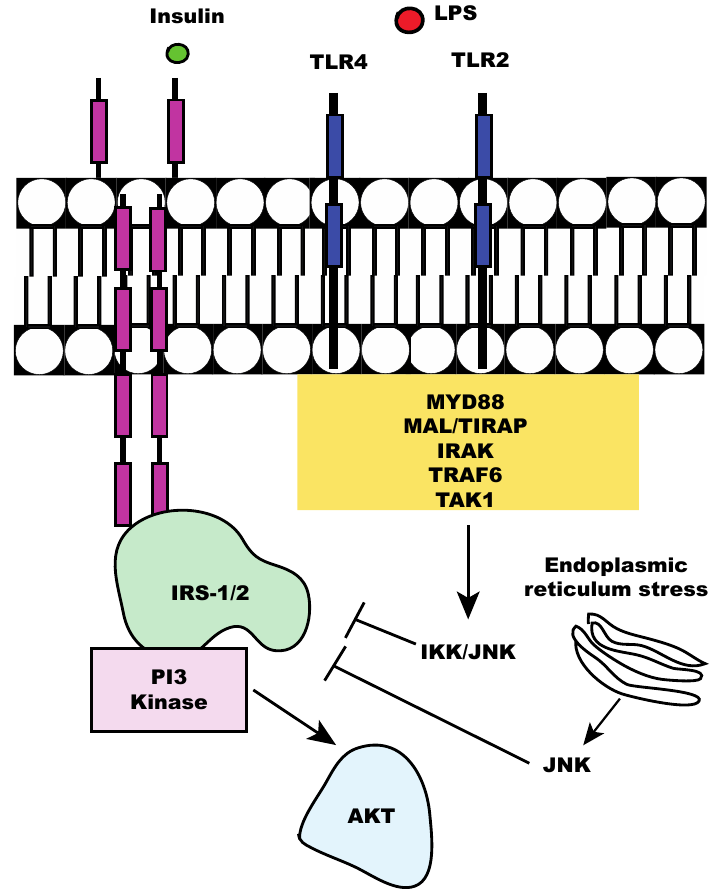
Figure 2. Insulin signaling is affected by Toll-like Receptor (TLR)2 and 4 signaling. LPS: lipopolysaccharide; IRS: insulin receptor substrate; PI3K: phosphoinositide 3-kinase; AKT: protein kinase B; IKK: IκB kinase; JNK: c-Jun N -terminal kinase;